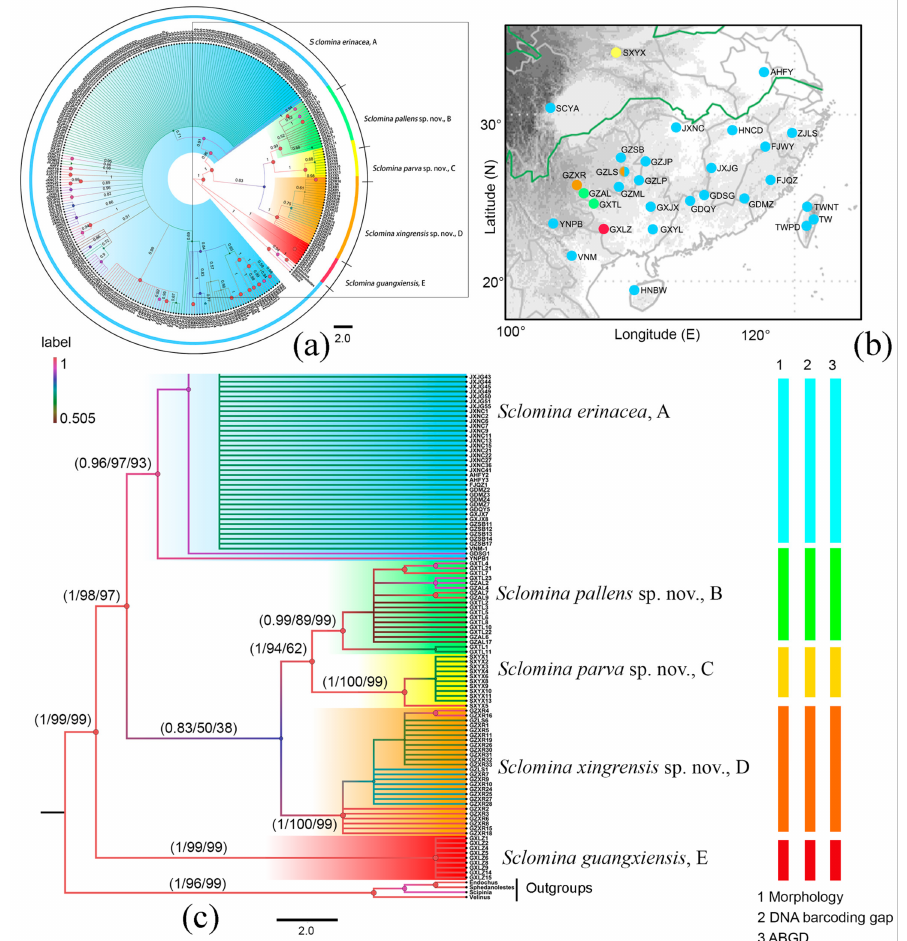
Figure 1. ( a ) Bayesian phylogenetic tree of cytochrome c oxidase subunit I ( COI ) sequence for 307 terminals of Sclomina ; ( b ) enlarged box from ( a ); the results of Bayesian inference (BI), maximum likelihood (ML) and neighbor-joining (NJ) analyses agree with those of the three different species delimitation approaches, morphology identification, DNA barcoding gap and ABGD (automatic barcoding gap discovery) analysis. The numbers above the branches are the posterior probabilities of the Bayesian inference (BI), the bootstrap values of maximum likelihood (ML) analyses, and neighbor- joining (NJ). ( c ) Distribution map of the 5 Sclomina species and locality group terminals (for sample codes, see Table A1). The clades/species identified in this study are indicated in different colors: blue, Sclomina erinacea Stål, 1861, clade A; green, Sclomina pallens sp. nov., clade B; yellow, Sclomina parva sp. nov., clade C; orange, Sclomina xingrensis sp. nov., clade D; red, Sclomina guangxiensis Ren, 2001, clade E. Legend label, the Bayesian posterior probability (BPP) of Figure